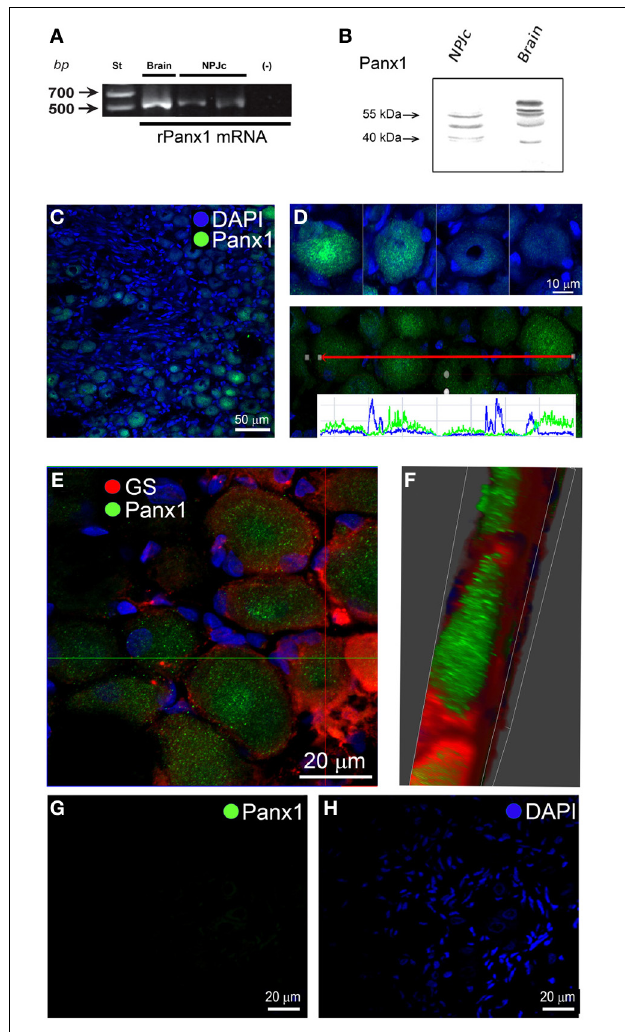
FIGURE 2 | Panx1 is expressed in NPJcs. (A) RT-PCR detection of Panx1 mRNA in total extracts of NPJcs. Each lane shows Etd + -stained amplicons: lane 1 correspond to brain extracts used as positive control; lanes 2 and 3 correspond to two independent NPJc samples and lane 4 correspond to a reaction that was performed without RNA (negative control). (B) Panx1 protein was detected by Western blot analyses. In NPJc homogenates, several reactive bands with electrophoretic mobility were found. However, a band of approximately 50kDa was clearly detected in rat NPJc and brain samples. (C) Confocal immunofluorescence detection of Panx1 in NPJc slices. (D) Four examples of neurons expressing Panx1 are presented (upper panel). Digital analysis of a zone of the NPJc expressing Panx1 (lower panel, green line) and DAPI staining (lower panel, blue line) were performed, showing that Panx1 does not co-localize with DAPI, which mainly marks the SGC nuclei. (E) Co-immunolabeling of Panx1 (Green) and GS (Red) (F) 3D module of ZEN 2011 used to visualize the data by transparent rendering Z-reconstruction. (G) Indirect immunofluorescence in a slice of NPJc when Panx1 primary antibody was omitted. (H) DAPI staining showing cell nuclei of the same field presented in panel (G) .